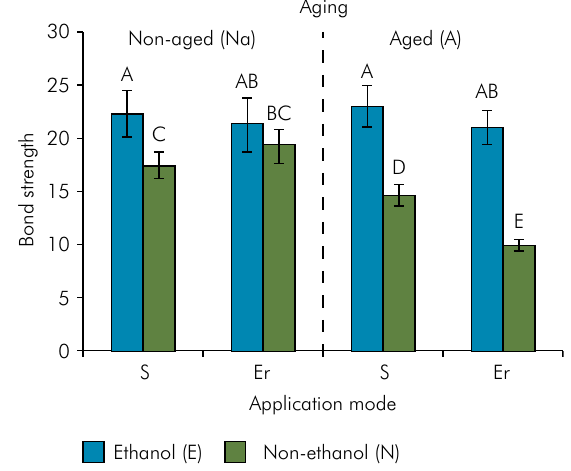
Figure 2. Graph presenting interaction among